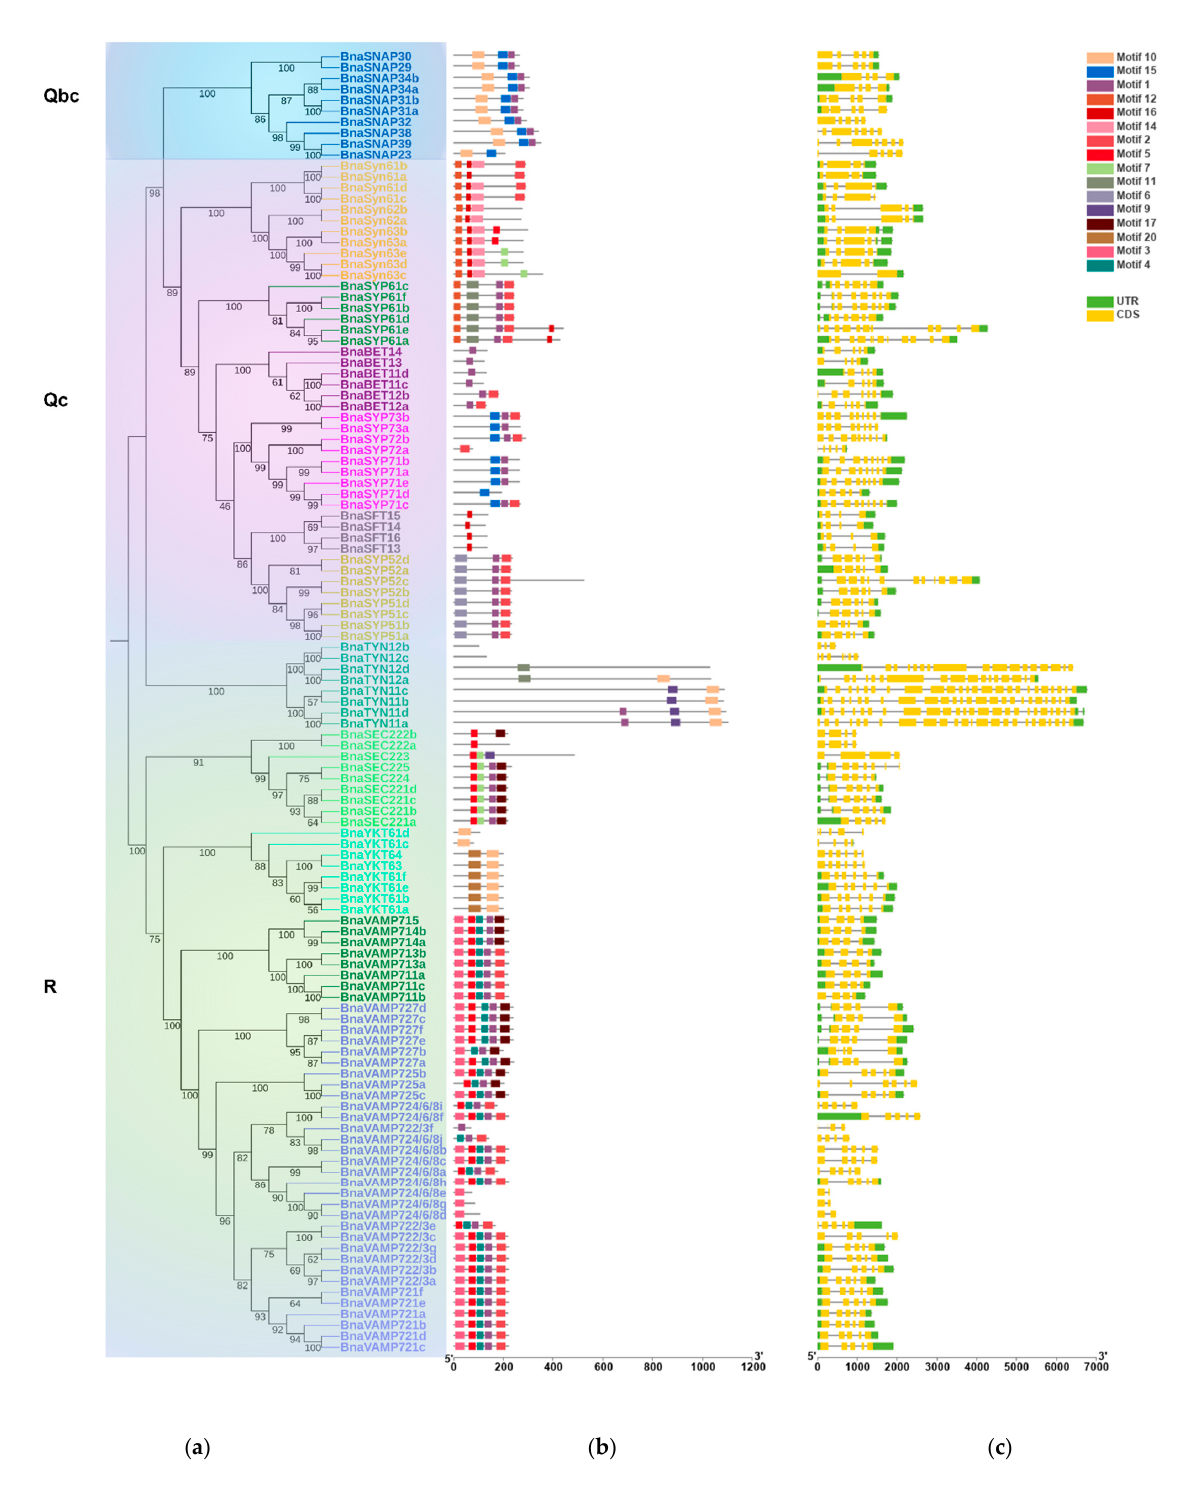
Figure 2. Gene intron/exon structures and protein conserved motifs of BnaSNAREs. ( a ) Phylogenetic tree of BnaSNARE proteins. ( b ) Conserved motif arrangements of BnaSNAREs. Twenty conserved motifs labeled with different colors were found in the BnaSNAREs sequences using the MEME program. Sequences of the conserved motif are presented in Table S5. ( c ) Exon-intron organizations of BnaSNAREs . The green boxes represent 5 (cid:48) or 3 (cid:48) untranslated regions, yellow boxes represent exons, and black lines represent the introns. The lengths of the exons and introns can be determined by the scale at the